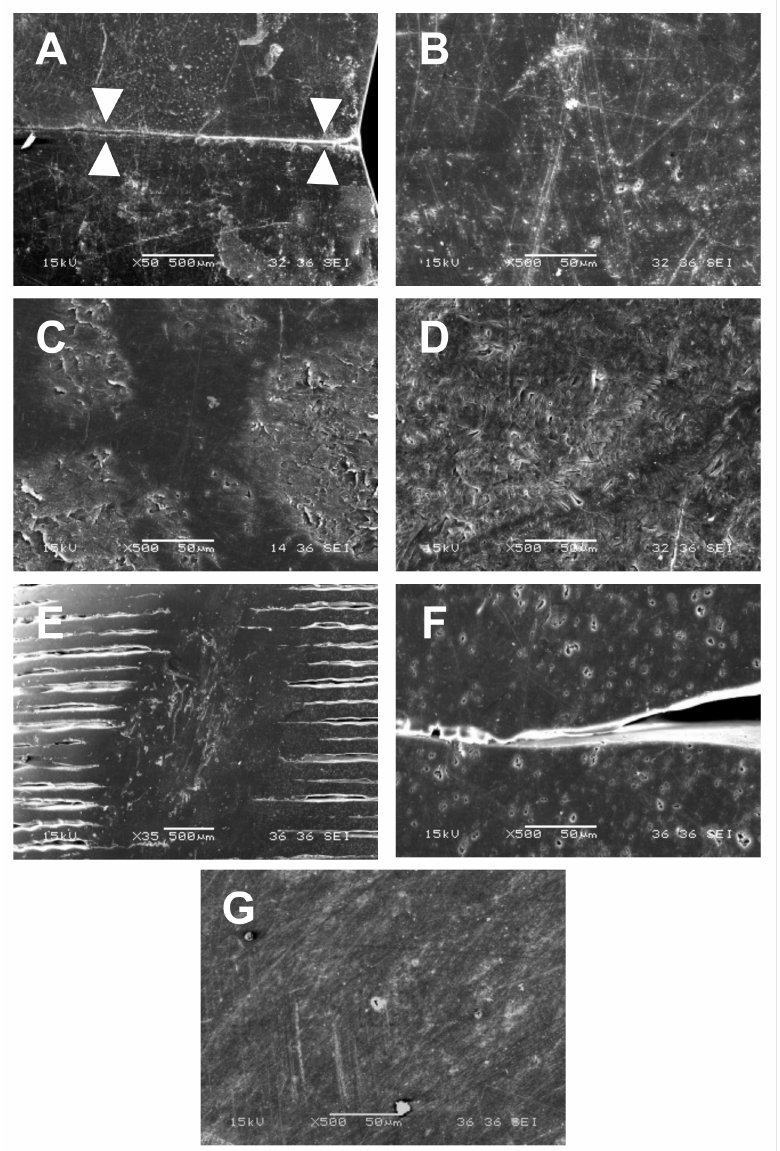
Figure 6. Morphology of the crowns’ outer surfaces. Magnification 50 × ( A , E ) and 500 × ( B – D , F , G ). ( A , B ): Prefabricated polycarbonate crown; ( C ): Milled polycarbonate crown (ZPF); ( D ): Milled poly- carbonate crown (TBP); ( E , F ): 3D-printed polycarbonate crown; ( G ): Milled PMMA crown. White triangles in “A” point at the parting line. Despite polishing, irregularities and minor defects were observed on the surfaces of all crowns. Gaps between the filaments were observed on outer surfaces of 3D-printed crowns. The surfaces of PMMA crowns were smoother compared to polycarbon- ate